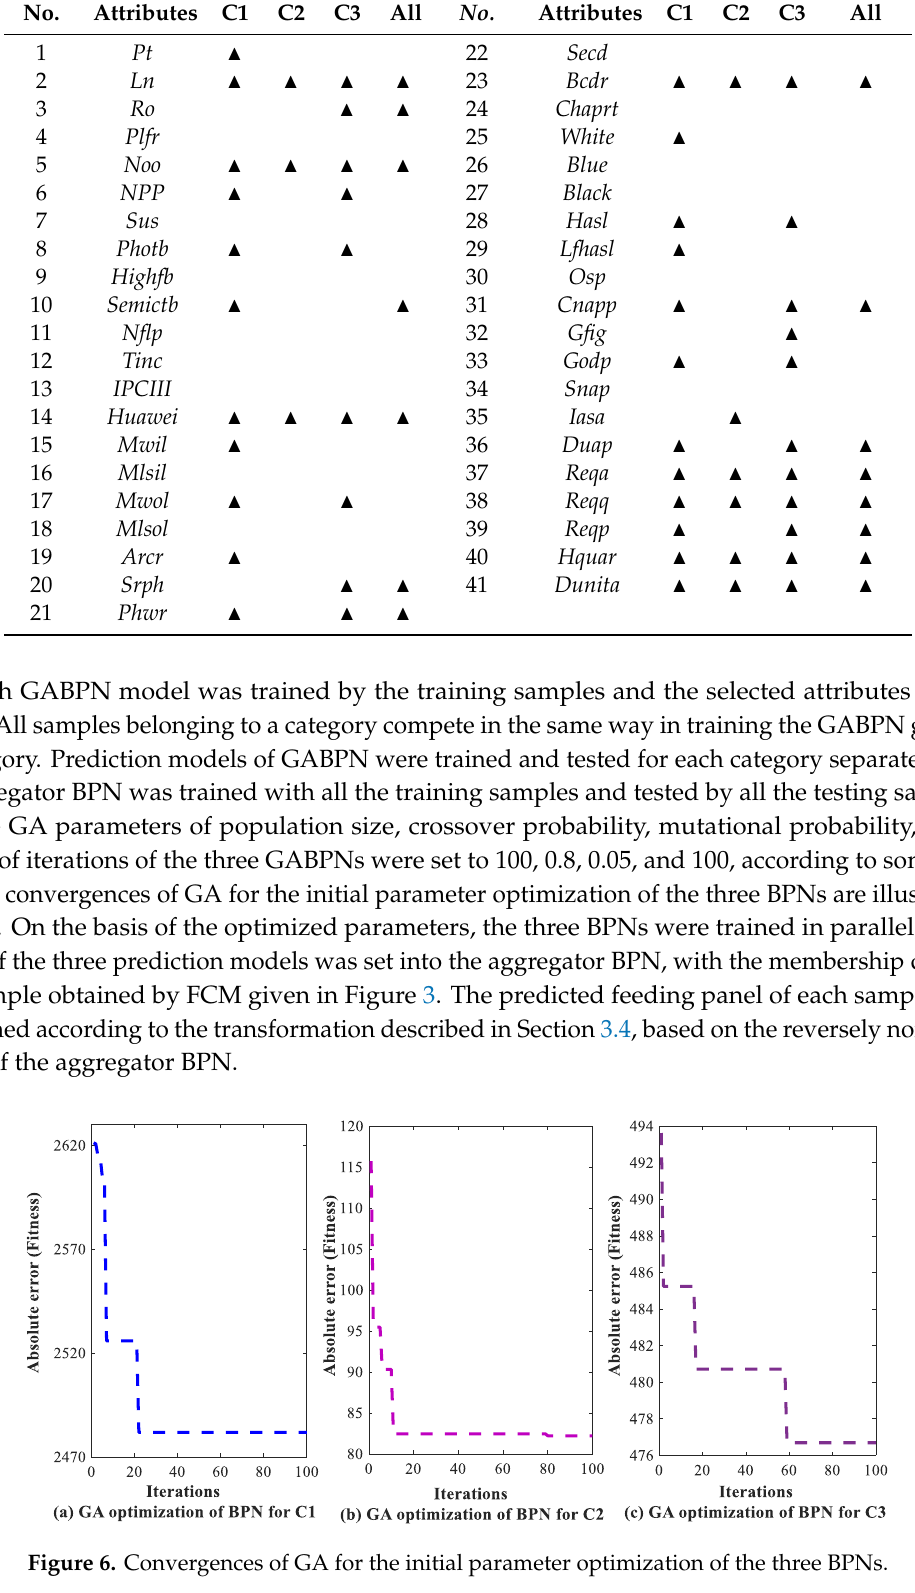
Figure 6. Convergences of GA for the initial parameter optimization of the three BPNs.